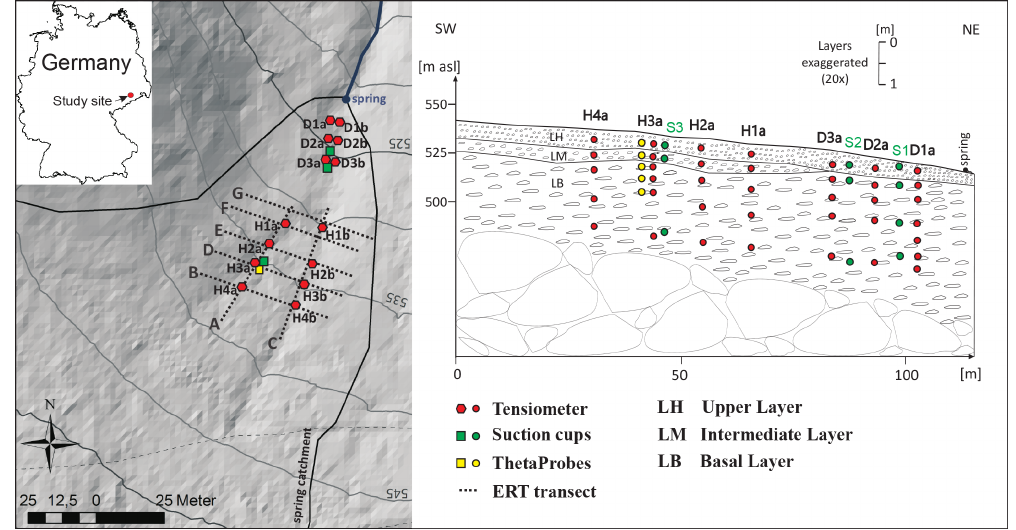
Figure 1. Study site with locations of ERT profiles and hydrometric stations (left panel; data source: ATKIS ® -DGM2, Landesvermes- sungsamt Sachsen, 2008) and profile section with installation depths of tensiometers, soil moisture sensors and suction cups (right panel). Table 1. Properties of cover beds from the study site ( n ≥ 15 per layer) – adapted from Moldenhauer et al. (2013). Soil texture Hydraulic Soil Colour Clay Silt Sand Clasts Bulk density conductivity Layer horizon (moist) (%) (%) (%) (%) (gm − 3 ) Porosity (cmd − 1 ) ∗ LH A/Bw 10YR/5/8 14 52 34 36 1.2 0.55 27 LM 2Bg 10YR/5/4 12 53 35 43 1.5 0.43 9 LB 3CBg 10YR/5/3 7 22 71 56 1.7 0.36